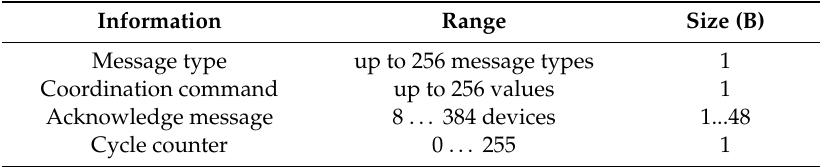
Table 2. Data model of the downlink messages transferred by the LoRaWAN infrastructure to IPSs. IPS: Interface Protection